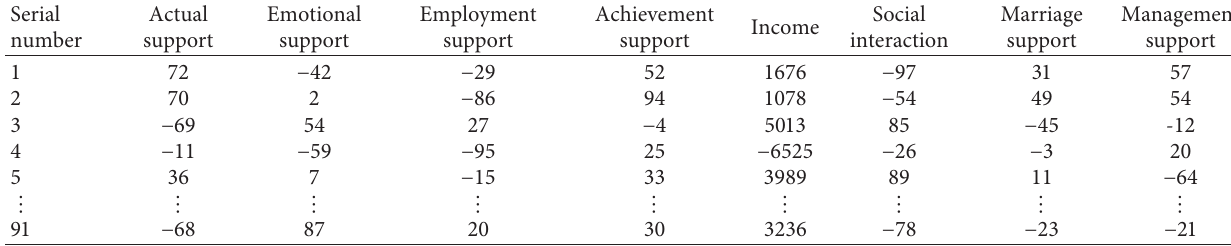
Table 1: Athlete social support attribute stake table.